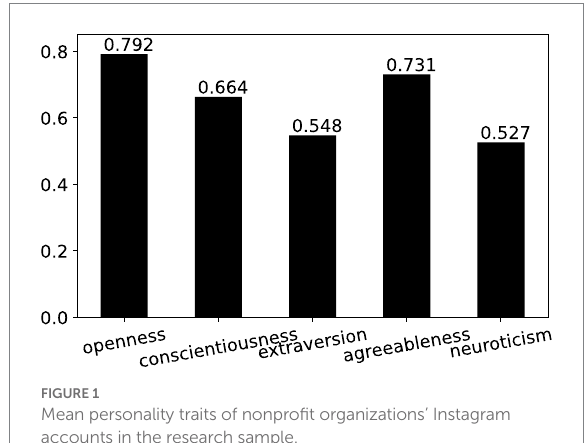
FIGURE 1 Mean personality traits of nonprofit organizations’ Instagram accounts in the research